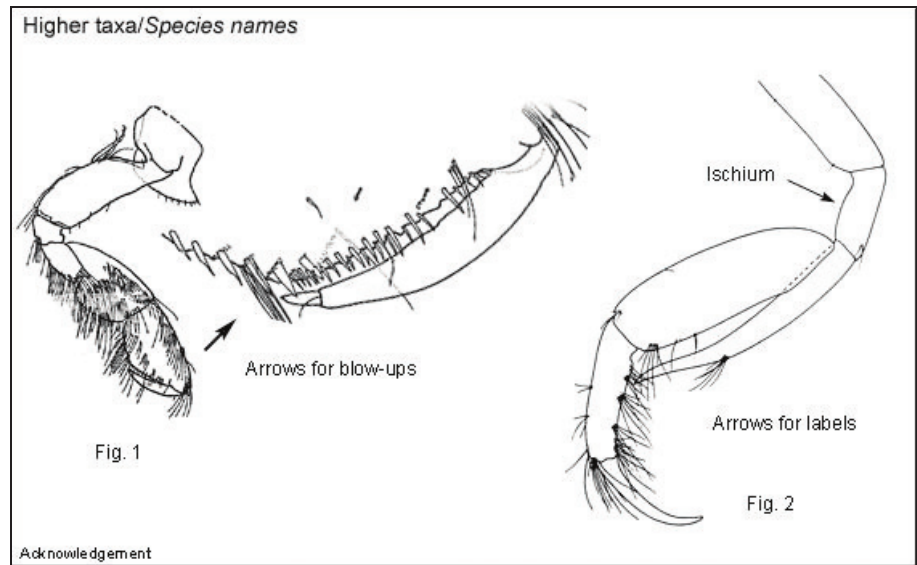
Figure 80. Example for character